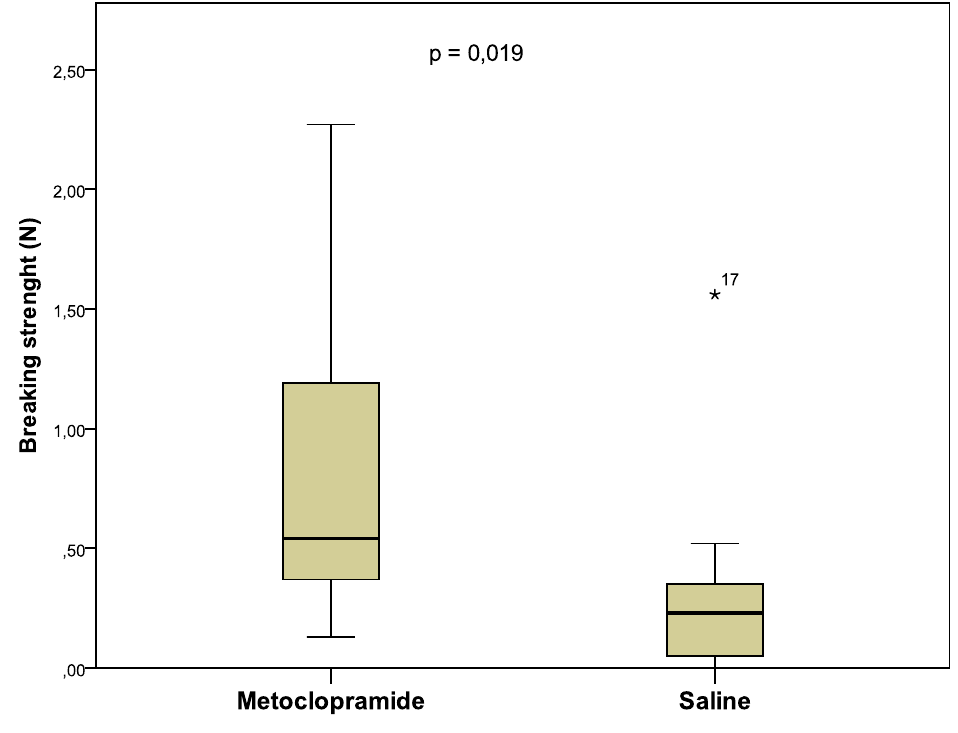
FIGURE 3 - Breaking strength of rupture of the abdominal wall of the animals by groups E3 (Metoclopramide) and C3 (saline). Values are expressed in Newtons (N)